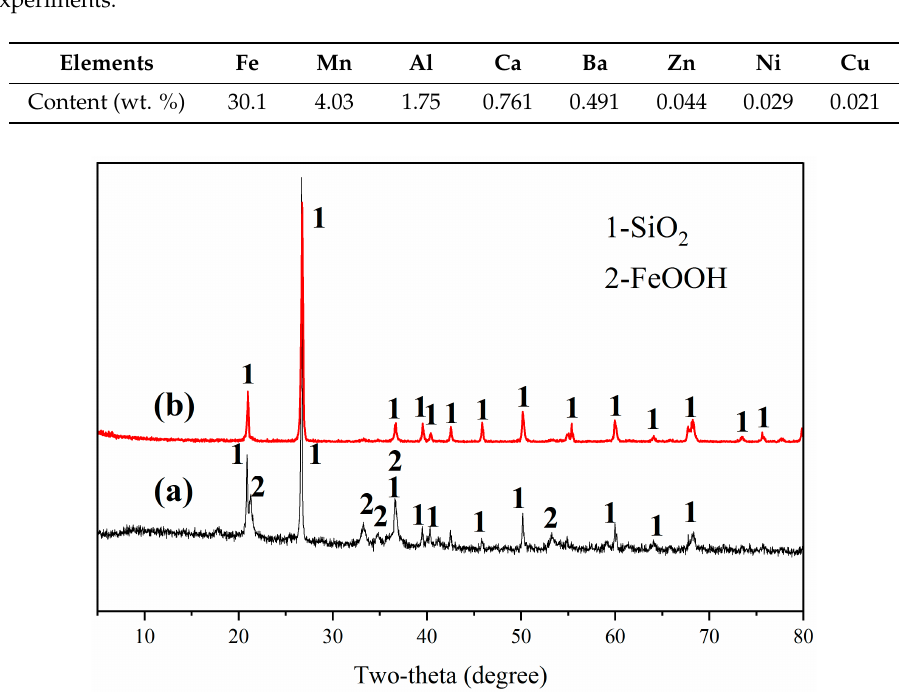
Figure 1. The X-ray diffraction of pattern of ( a ) the PAR; ( b ) the leaching residue after roasting-acid leaching.